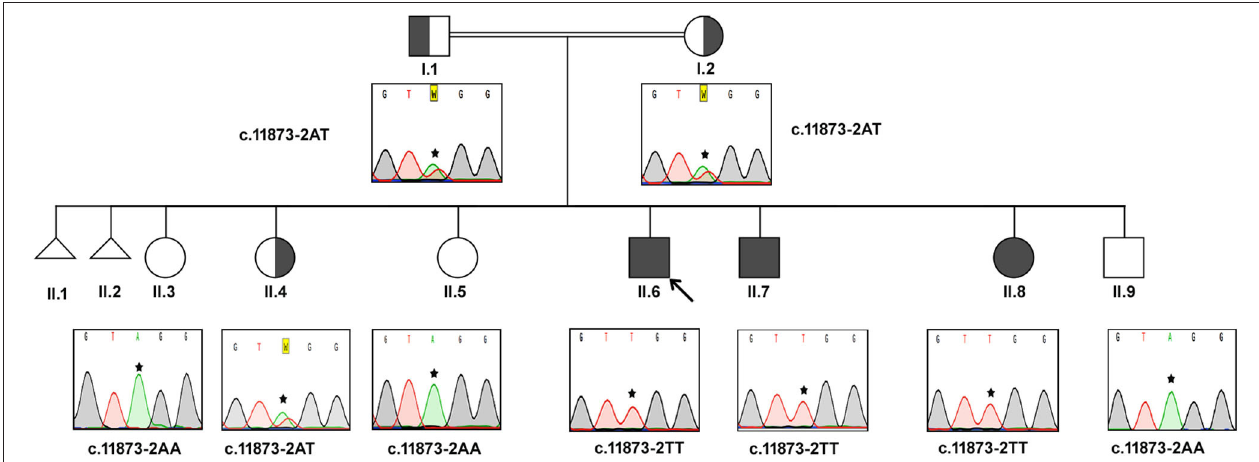
FIGURE 1 | Pedigree and the DNA sequence analysis of AS Family A. Proband. (II.6) is indicated by the arrow. Each DNA chromatogram (reverse strand) shows the result from the respective Sanger sequencing confirming the status of the mutation. The proband is having the homozygous TT mutation at the splice site (c.11873–2). Both parents are heterozygous for the given mutation. All three affected siblings show homozygous mutations while the unaffected siblings were either heterozygous for the mutation or homozygous for the normal allele.